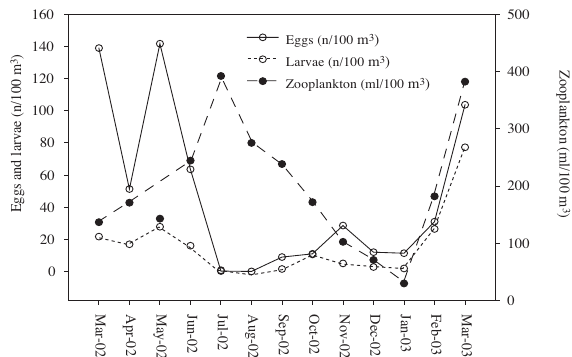
F IG . 4. – Temporal evolution of the mean monthly abundance of wedge sole eggs and larvae (number/100 m 3 ) and zooplankton (mL/100 m 3 ) during the period March 02-March 03.